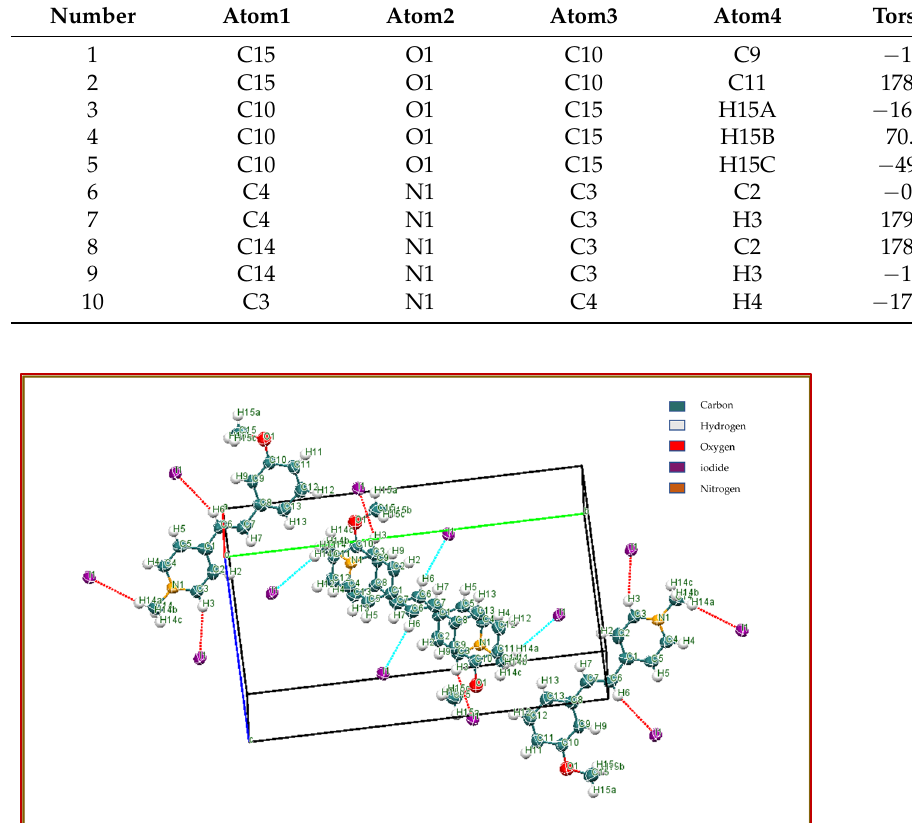
Figure 4. Packing diagram for MMPI. Table 1. Data collection and structure refinement for MMPI crystal.